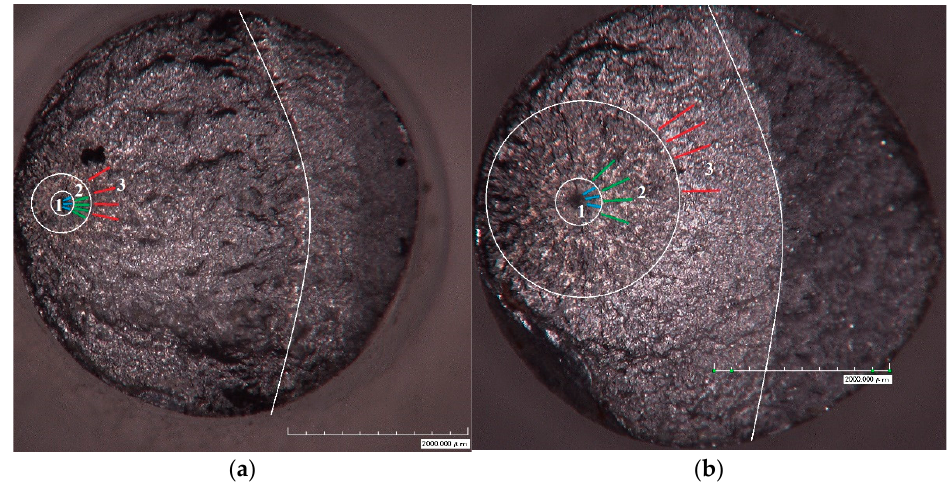
Figure 6. ( a ) The fracture surface of specimen No. 1 ( σ = 138 MPa, N = 7.51 × 10 8 ). ( b ) The fracture surface of specimen No. 2 ( σ = 120 MPa, N = 7.82 × 10 8 ). Colored lines illustrate the directions of analyzed profiles in zones 1 (blue), 2 (green), and 3 (red).